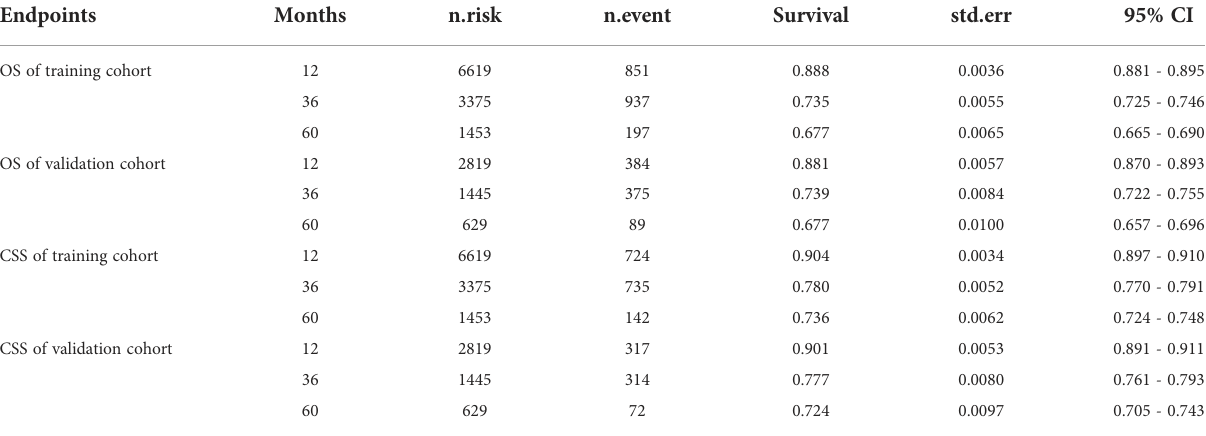
TABLE 3 Survival analysis of OS and CSS in the training cohort and validation